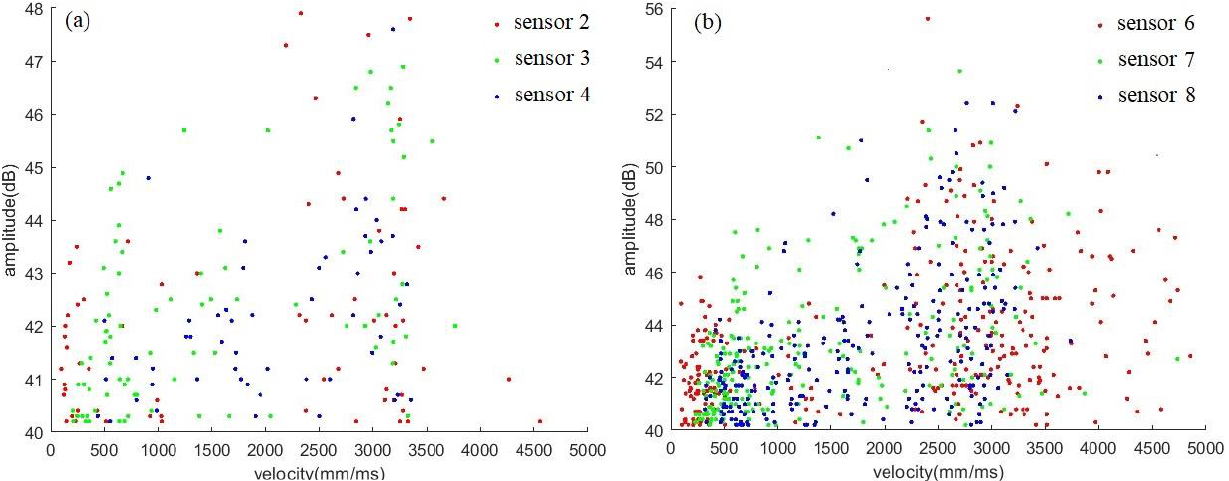
Figure 11. Result representation of velocity – amplitude after applying AIC: ( a ) Nano30 sensors; ( b ) VS150-RIC sensors.